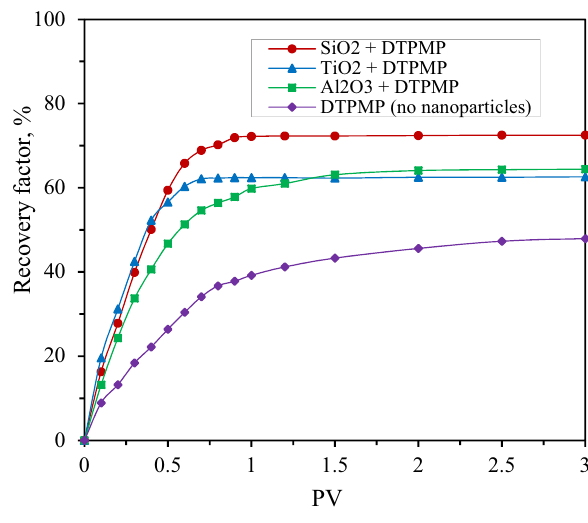
Fig. 9 The changes in recovery factor during LSWI with and with- out the use of TiO 2 , Al 2 O 3, and SiO 2 nanoparticles in the presence of DTPMP (25 ppm) at different pore